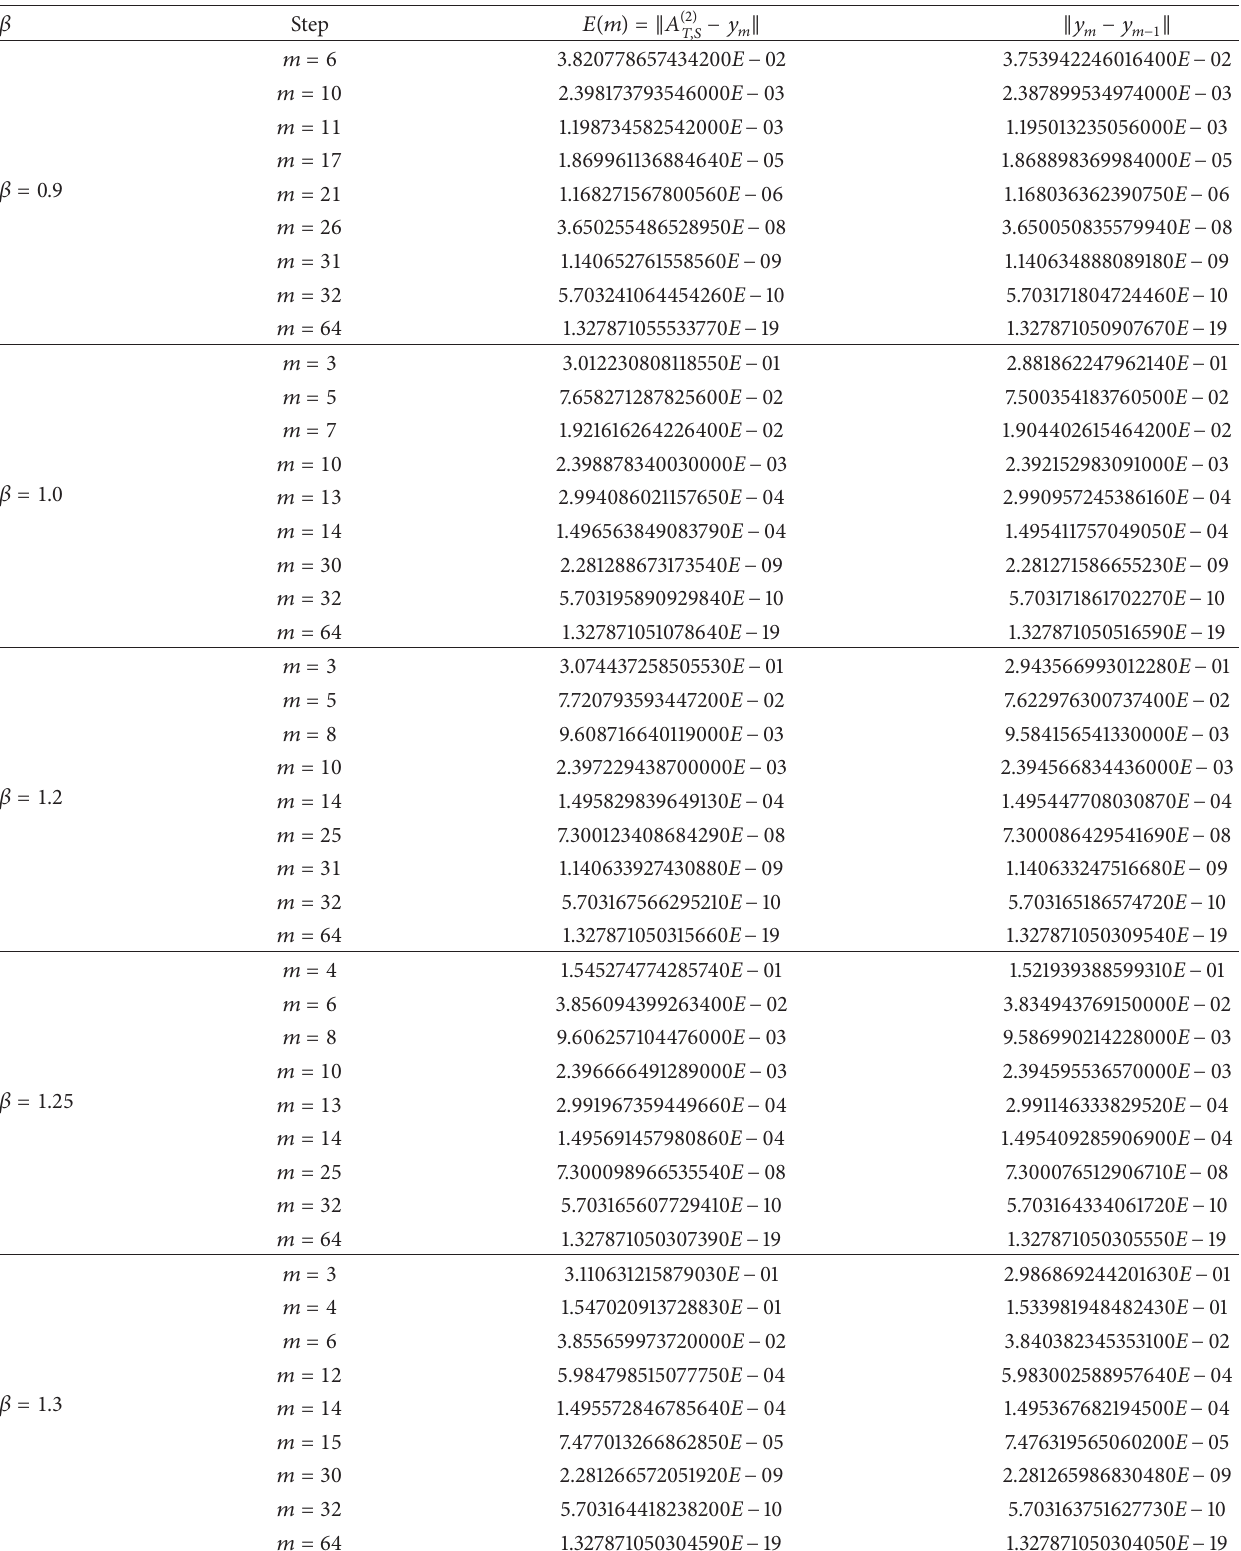
Table 1: Results for computing 𝐴 (2) 𝑇,𝑆 by using iteration